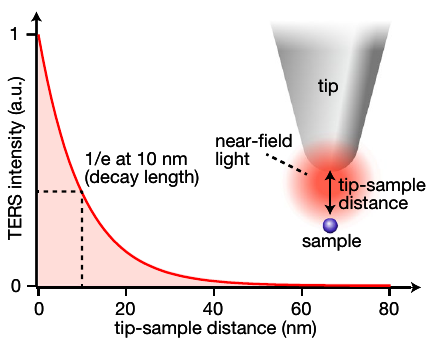
Figure 1. TERS intensity dependence on the tip-sample